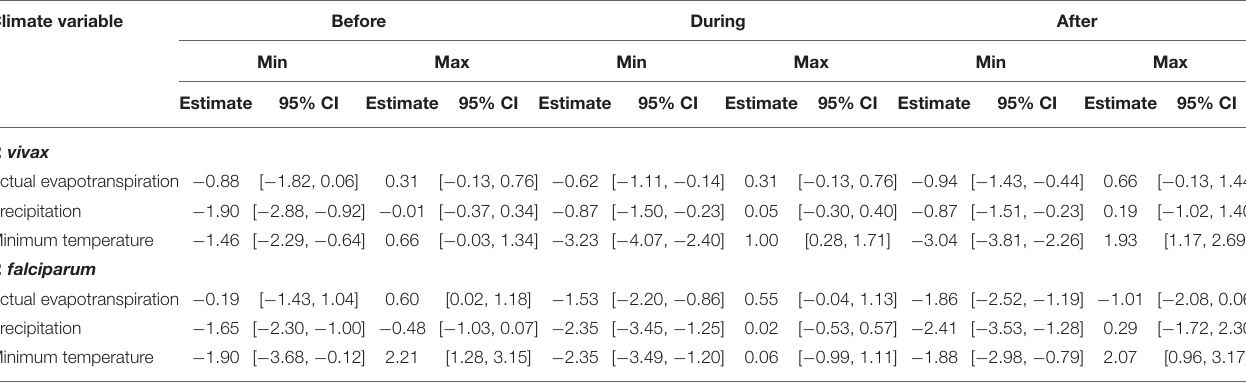
TABLE 2 | Maximum and minimum fitted effects of the meteorological variables of the adjusted models for the parasite species within three periods: before, during and after the PAMAFRO intervention. Climate variable Before During After Min Max Min Max Min Max Estimate 95% CI Estimate 95% CI Estimate 95% CI Estimate 95% CI Estimate 95% CI Estimate 95%